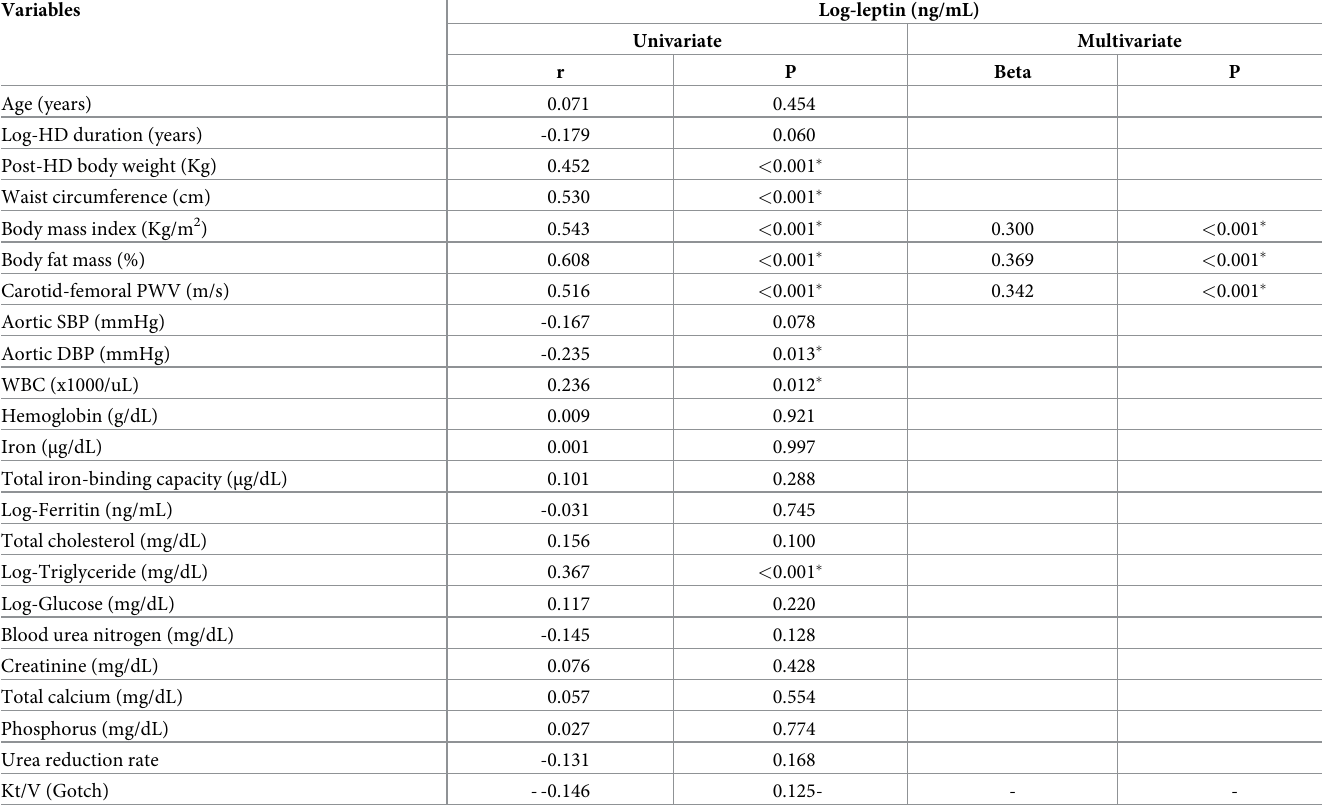
Table 4. Correlation between serum leptin levels and clinical variables among 112 hemodialysis patients.